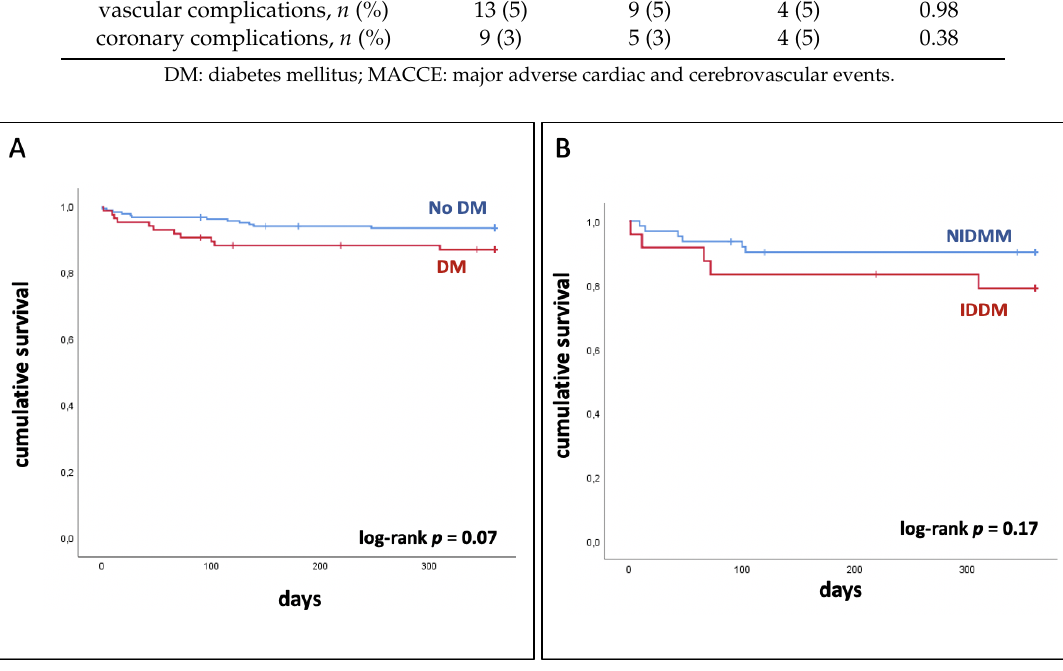
Figure 2. Association of coronary anatomical complexity with clinical outcomes in diabetic patients ( A ) In-hospital MACCEs and ( B ) Kaplan–Meier estimates of one-year survival according to baseline SYNTAX I score; DM: diabetes mellitus; MACCE: major adverse cardiac and cerebrovascular events. 4. Discussion